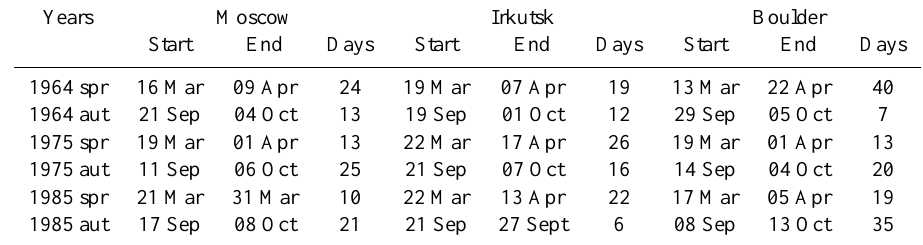
Table 3.1. Start and end dates of the equinoctial transitions for the longitudinal chain of stations during solar minimum Years